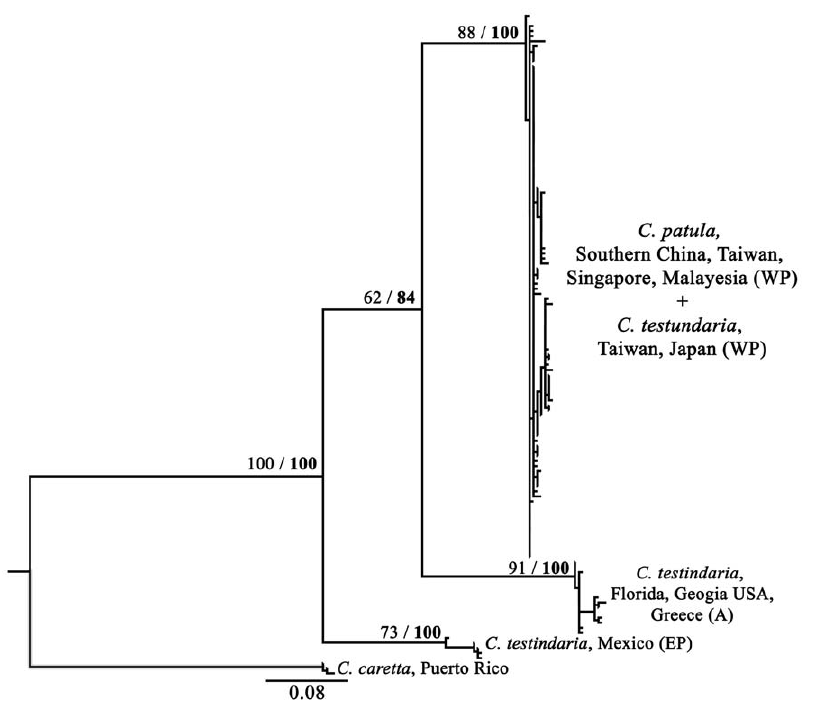
Figure 4. Maximum likelihood (ML) tree of Chelonibiatestudinaria and C.patula in this study with sequences of C.testudinaria from Rawson et al. (2003) (GenBank accession nos.: AY174312–16, 24–28, 34–8, 42–46, 58–62) and outgroup C.caretta (FJ385728-30). ML and Bayesian inference (BI) analyses yield the same topology. Bootstrap (1,000 replicates) values for ML (normal) and the posterior probabilities for BI (bold) analyses are indicated at the nodes. (EP: eastern Pacific; WP: western Pacific; A: Atlantic).